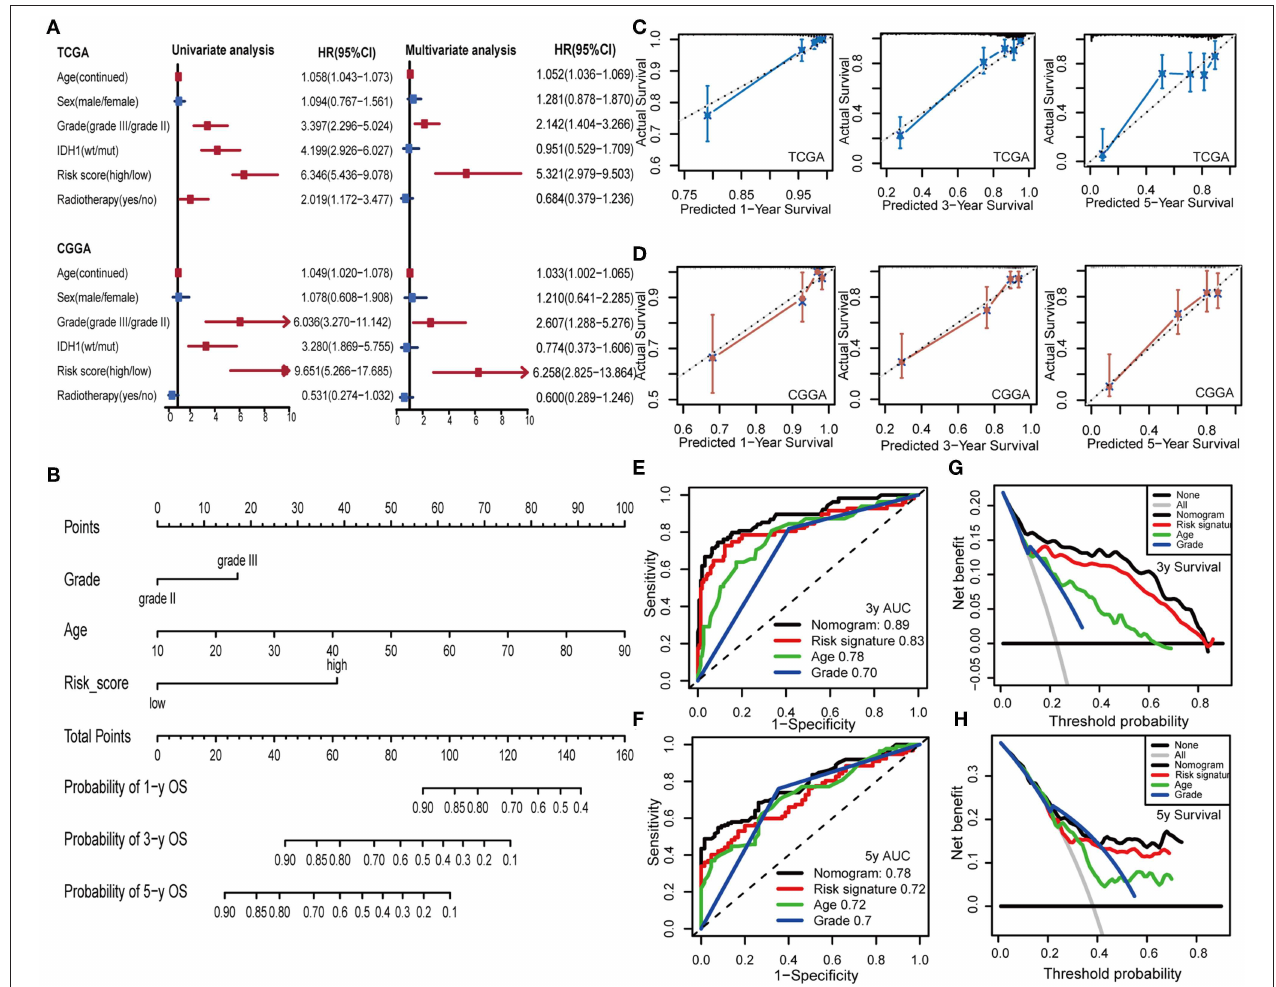
FIGURE 8 | Construction and validation of the nomogram model. (A) Univariate and multivariate Cox analyses indicated that IPS was significantly associated with OS in both TCGA and CGGA sets. Red indicates statistical significance, and blue indicates no statistical significance. (B) Nomogram model for predicting the probability of 1-, 3-, and 5-year OS in LGGs. (C,D) Calibration plots of the nomogram for predicting the probability of OS at 1, 3, and 5 years in TCGA and CGGA cohorts. (E,F) Time-dependent ROC curve analyses of the nomogram model, risk signature, age and tumor grade in TCGA cohort. (G,H) Decision curves of the nomogram predicting 3- and 5-year OS in TCGA